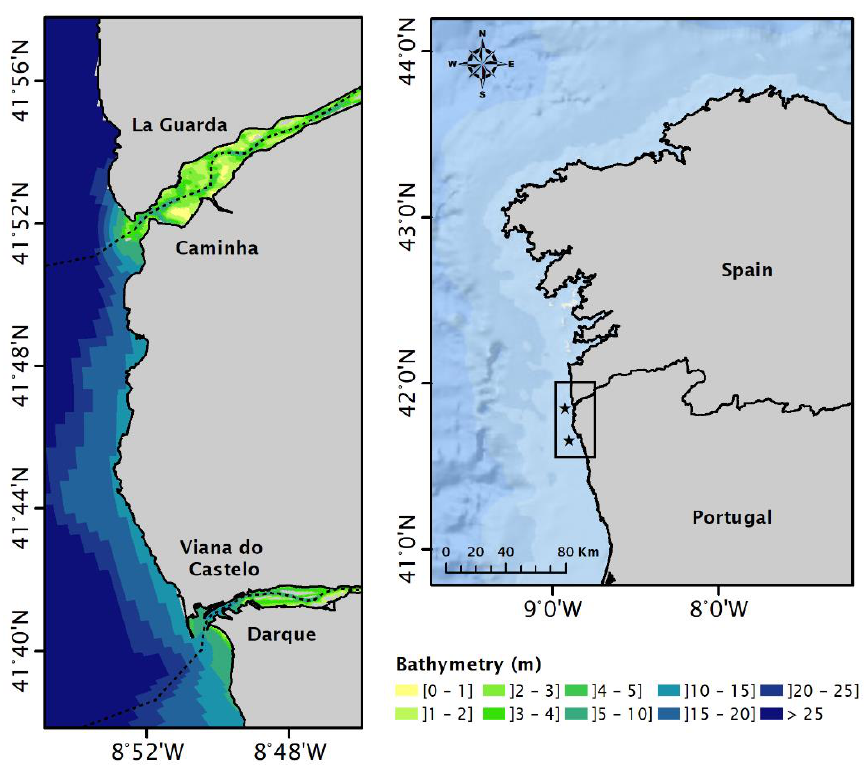
Figure 1. Minho and Lima estuaries location and respective bathymetry. The star symbols indicate the location of the estuaries mouth, and the dotted line represents the longitudinal sections where saline intrusion and the estuarine plume will be vertically